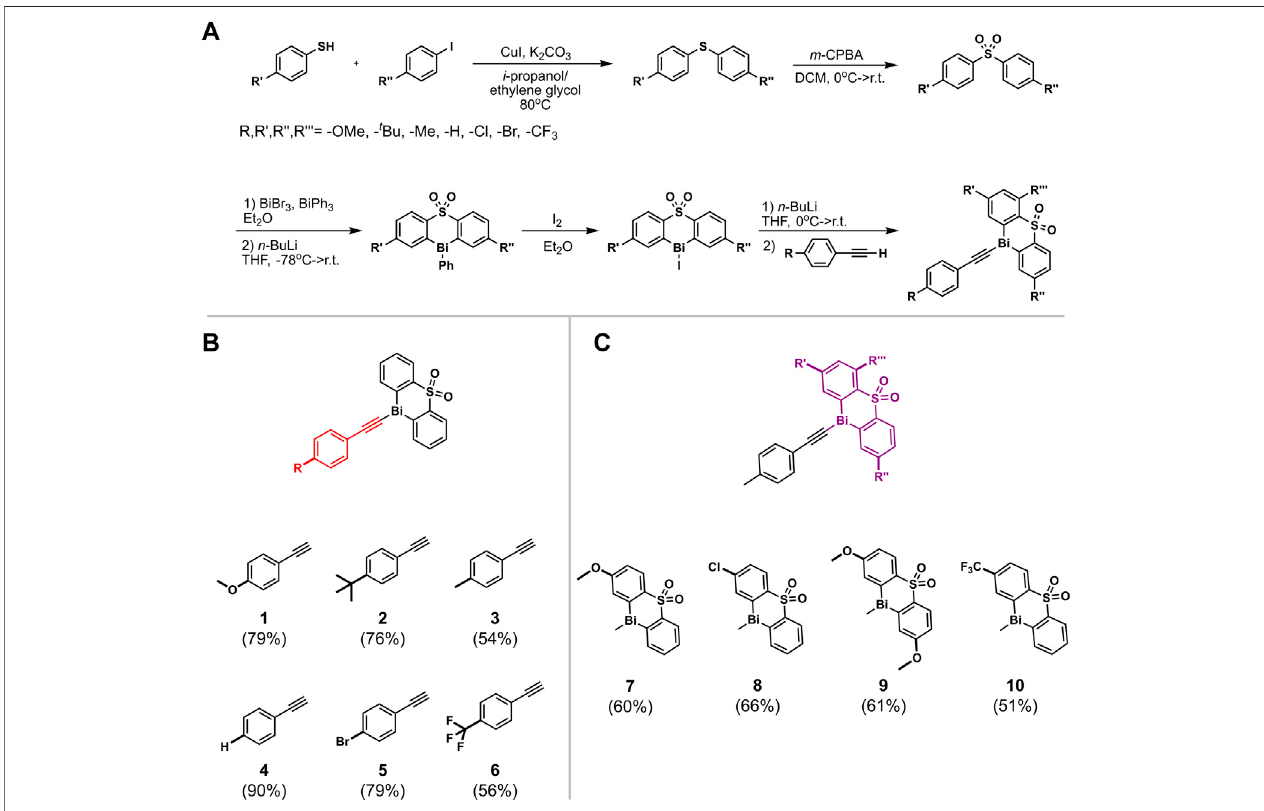
FIGURE 2 | (A) Synthetic route for the synthesis of diphenyl sulfone bismuth(III) acetylides (a) CuI, K 2 CO 3 , i -propanol/ethylene glycol, 80 ° C; (b) m -CPBA, DCM, MgSO 4 10eq., 0 ° C – > r.t.;(c) 1) BiBr 3 ,BiPh 3 ,Et 2 O, 2) n -BuLi, THF, − 78 ° C – > r.t.; (d) I 2 , Et 2 O, r.t.; (e) 1) n -BuLi, THF, − 78 ° C – > r.t. 2) para -substituted phenylacetylene; (B) diphenyl sulfone bismuth(III) acetylides; (C) 1-ethynyl-4-methylbenzene bismuth(III) acetylides with functionalized diphenyl sulfone